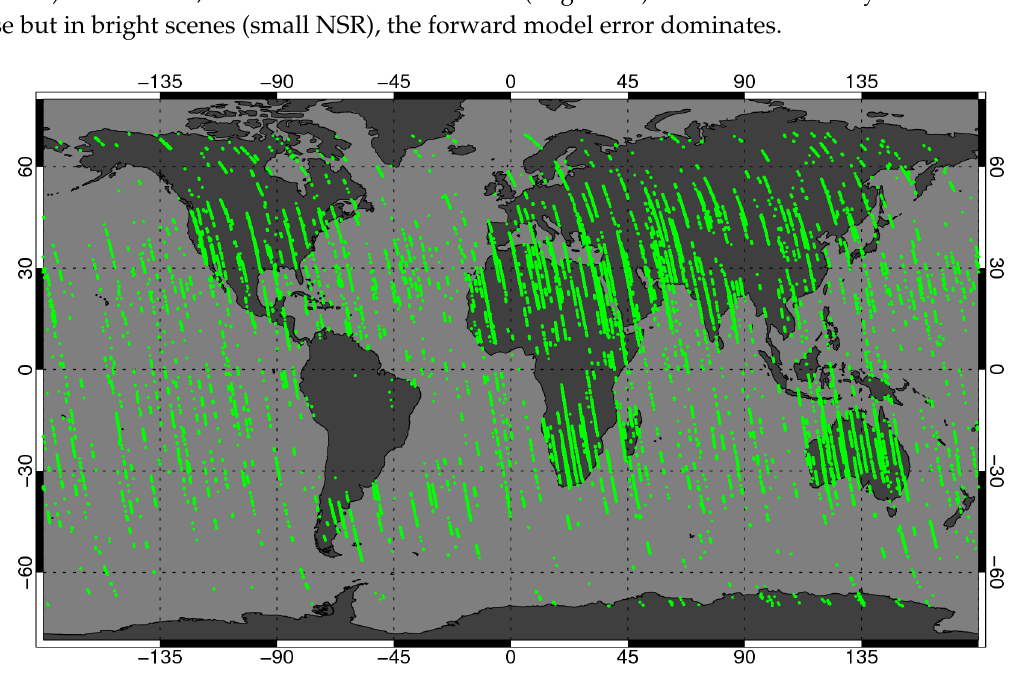
Figure 3. Sampling of all pre-filtered soundings analyzed in order to determine the noise model. The data set consists of 10% of all pre-filtered OCO-2 soundings (randomly selected) of 24 days in 2015 (13.01., 15.01., 14.02., 16.02., 10.03., 20.03., 03.04., 19.04., 08.05., 23.05., 08.06., 24.06., 15.07., 16.07., 15.08., 16.08., 15.09., 16.09., 15.10., 16.10., 15.11., 17.11., 12.12., 18.12.). This results in